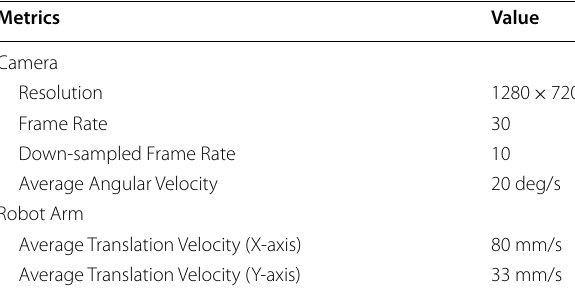
Table 3 Parameters’ setup for following experiments